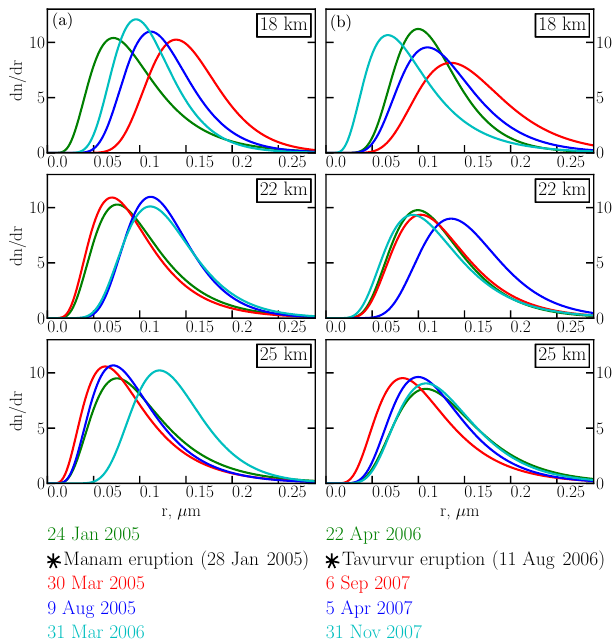
Figure 13. Evolution of the aerosol particle size distribution at dif- ferent altitudes (18, 22, 25km) after the Manam (a) and Tavuvur (b)